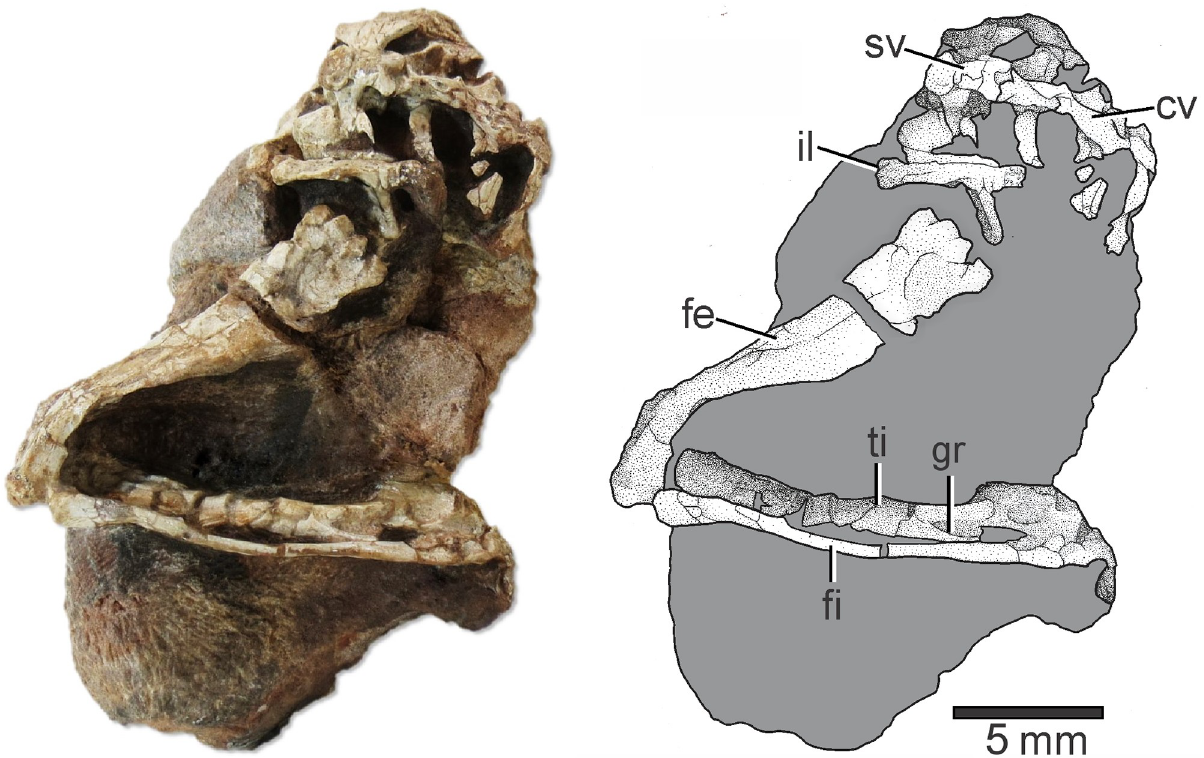
Fig 2. Elessaurus gondwanoccidens (UFSM 11471) from the Sanga do Cabral Formation (Lower Triassic), Brazil. Photograph and explanatory drawing respectively. Abbreviations: fe, femur; ti, tibia; gr, groove; fi, fibula; il, ilium; sv, sacral vertebra; cv, caudal vertebrae.